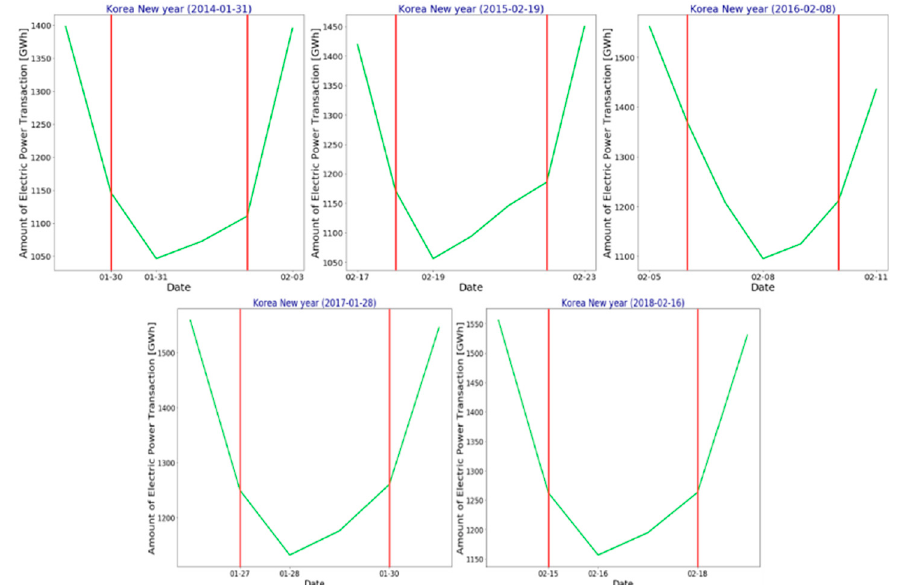
Figure 10. New year holidays in South Korea during 2014–2018.